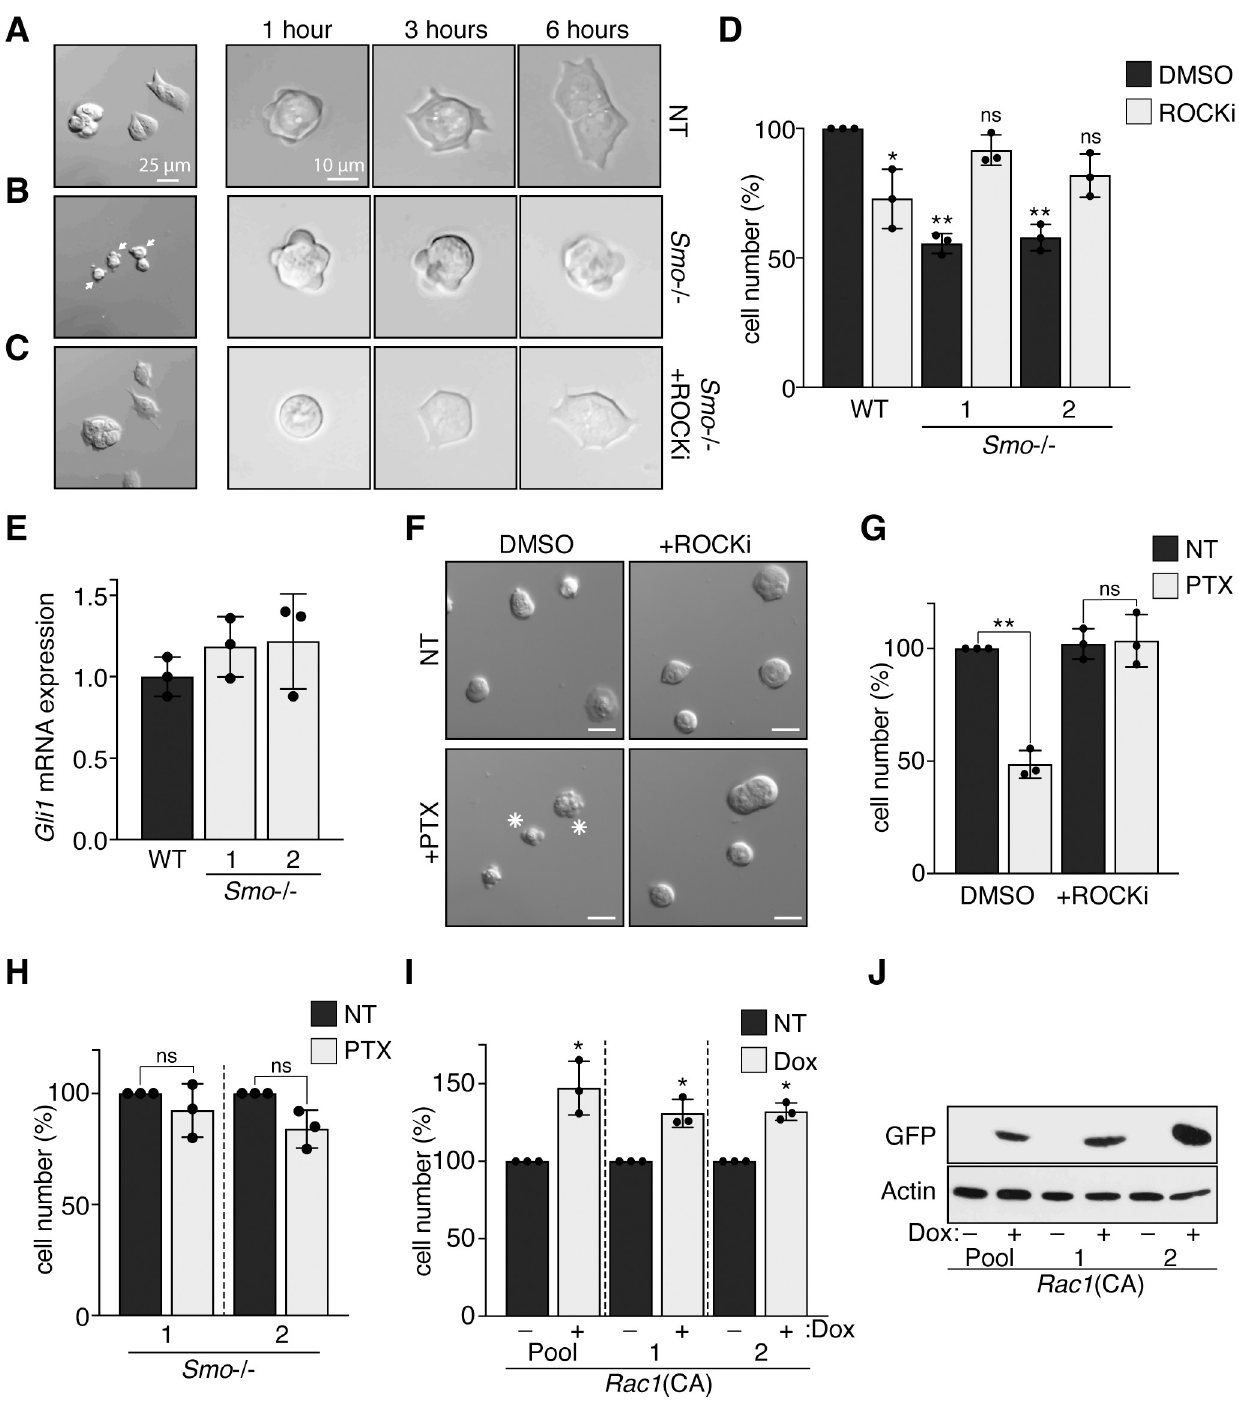
Fig 1. SMO supports survival of ESCs after dissociation. (A–C) SMO mutation induces blebbing and death after dissociation of ESCs. On the left, ESCs morphology 24 hours after dissociation and plating on Matrigel (A, untreated; B, pretreated with PMP for 24 hours; C, pretreated with PMP for 24 hours and with ROCKi after plating). Cells showing membrane blebbing (arrow), and apoptotic bodies (asterisk) are indicated. Images at 1, 3, and 6 hours after plating are shown on the right. (D) Survival of Smo −/− ESCs after 48 hours with or without addition of ROCKi. Asterisks denote statistical significance for difference from the untreated sample. (E) GLI transcription is not affected by Smo deletion in ESCs. Gli1 mRNA levels were measured by qPCR. Samples do not show statistically significant differences ( n = 3, biological replicates). (F–H) G i protein inhibition induces apoptosis in ESCs. (F) ESC morphology 24 hours after dissociation. Cells were pretreated with the G i specific inhibitor PTX and ROCKi. Apoptotic bodies are marked by an asterisk. Bars represent